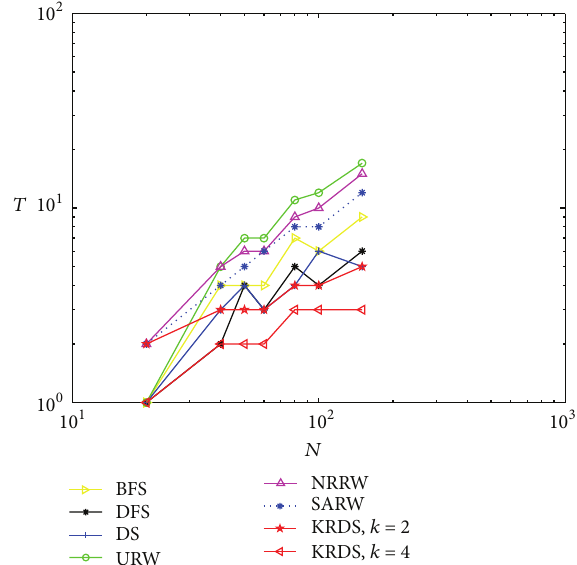
Figure 7: Plot of the average number 𝑇 of search steps versus the connection probability 𝑝 of the WSSWN in the log-log scale.